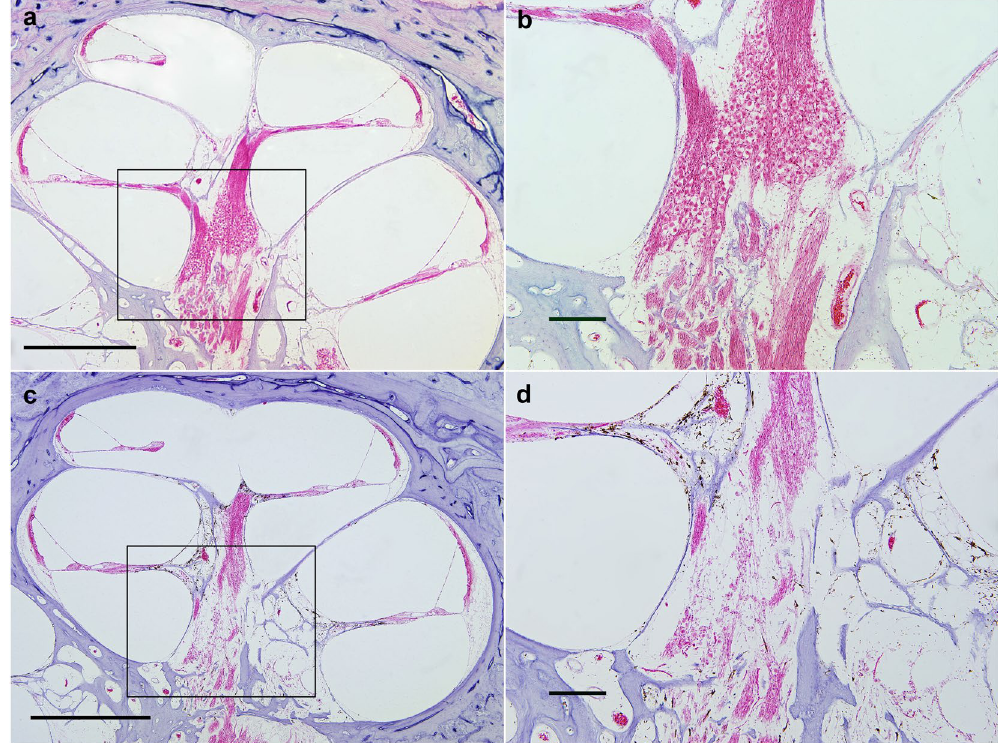
Figure 1. Representative cochlear histopathology in severe primary neural degeneration compared to age- matched control. In both examples, sensory structures are normal. ( a ) mid-modiolar section (4X) from the cochlea of a patient with appropriate SGN numbers for age; scale bar 1 mm. The boxed area is shown magnified in b. ( b ) 10X magnification of the modiolus in a; scale bar 200 μ m. ( c ) Mid-modiolar section (4X) from an age- matched patient with severe primary neural degeneration (Patient 19), showing 85% fewer total SGN cell bodies than expected for age; scale bar 1 mm. The boxed area is shown magnified in d. ( d ) 10X magnification of the modiolus in c; scale bar, 200 μ